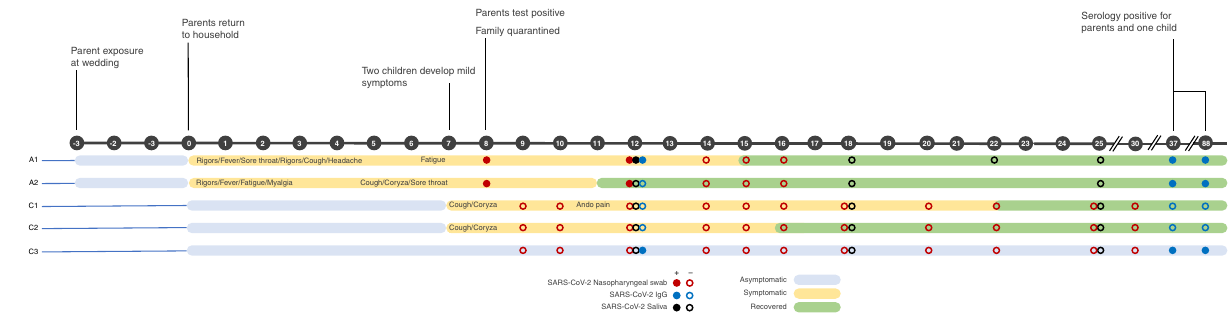
Fig. 1 Timeline of travel, exposure, symptoms, and selected results. Nasopharyngeal PCR, saliva, and serum antibodies are shown for each parent and child. Key events in the timeline are highlighted according to anumber of days following the return of parents to the